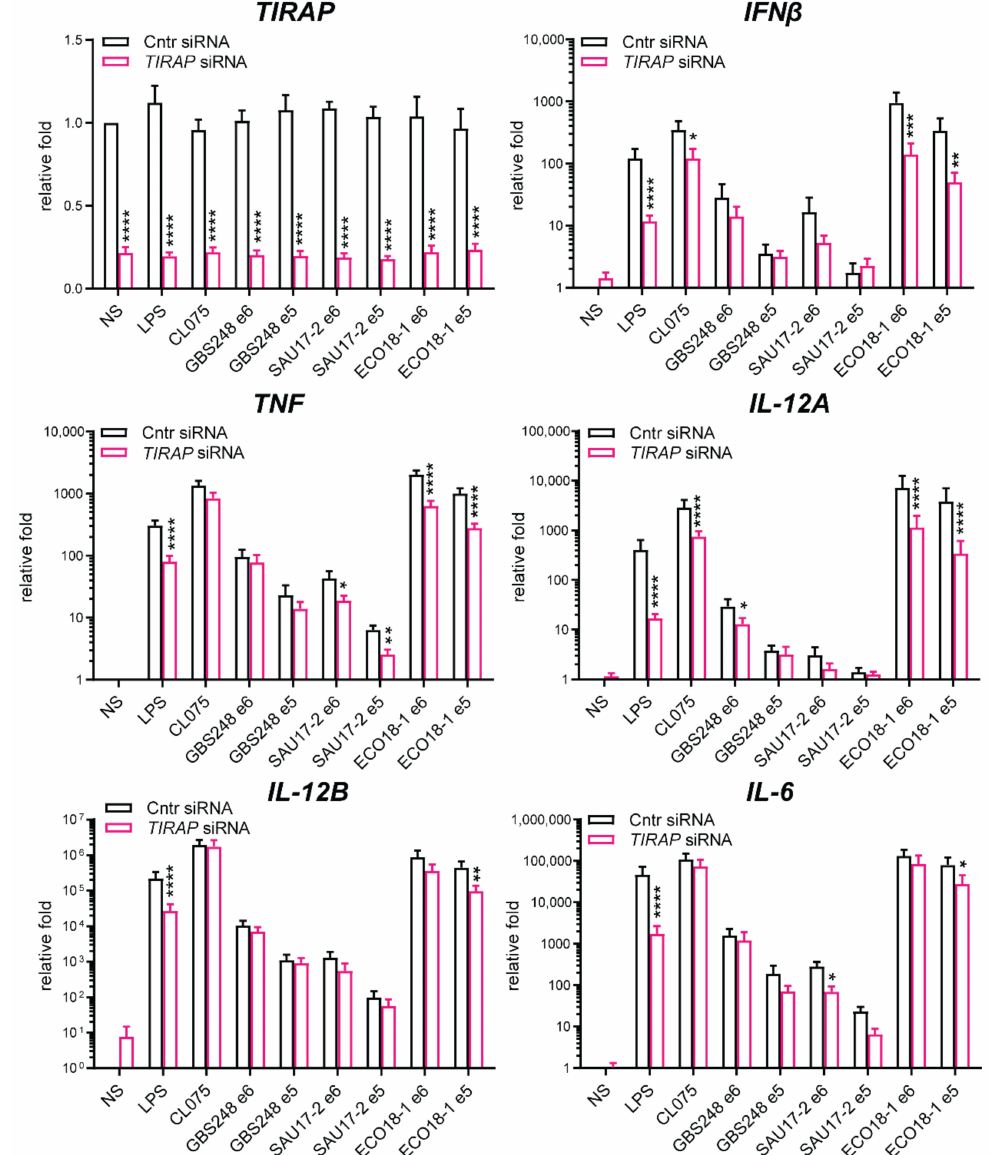
Figure 3. TIRAP silencing attenuates cytokine production from MDMs challenged with clinical isolates of E. coli (ECO), while affecting mainly IL-12A induction by Group B streptococcus (GBS) and pro-inflammatory cytokine induction by S. aureus (SAU). MDMs (5–6 donors in consecutive experi- ments) were pre-treated with TIRAP siRNA or control oligo and incubated with LPS (100 ng/mL), CL075 (1 µ g/mL), or live bacteria (GBS 248, SAU 17-2, and ECO 18-1) for a total time of four hours. The doses of bacteria were 1 × 10 5 /mL (e5) and 1 × 10 6 /mL (e6). This roughly corresponds to MOI 0.01 and 0.1 for GBS, MOI 0.02 and 0.2 for SAU, and MOI 0.1 and 1.0 for ECO. Gene expression was determined by RT-qPCR, normalized to untreated sample, and presented as a mean relative fold change +SEM. Statistical testing was done with 2-way RM-ANOVA and post-test (* p < 0.05, ** p < 0.01, *** p < 0.001, **** p <